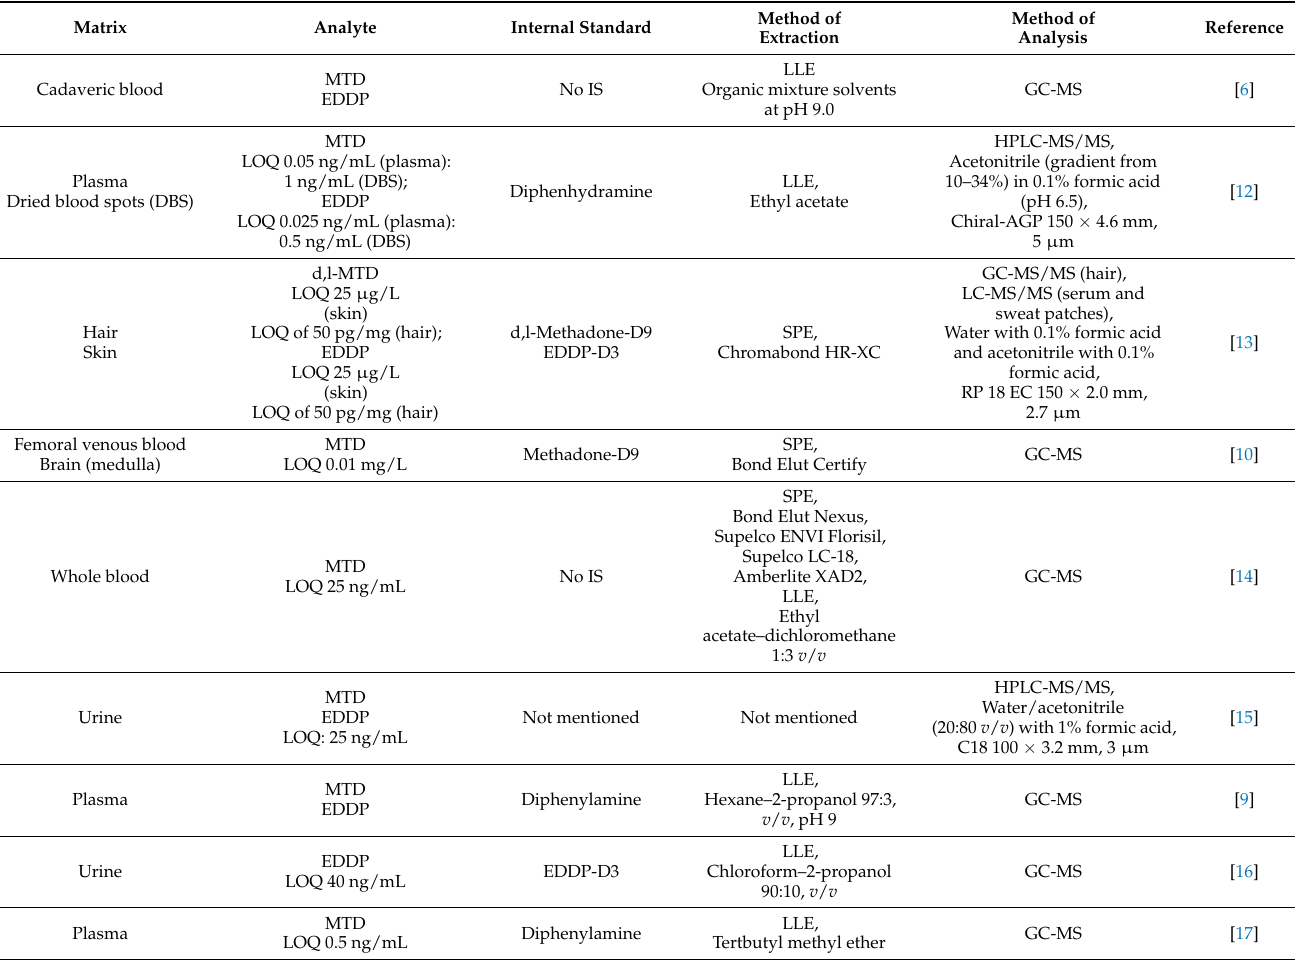
Table 1. Various methods for methadone and EDDP determination in biological